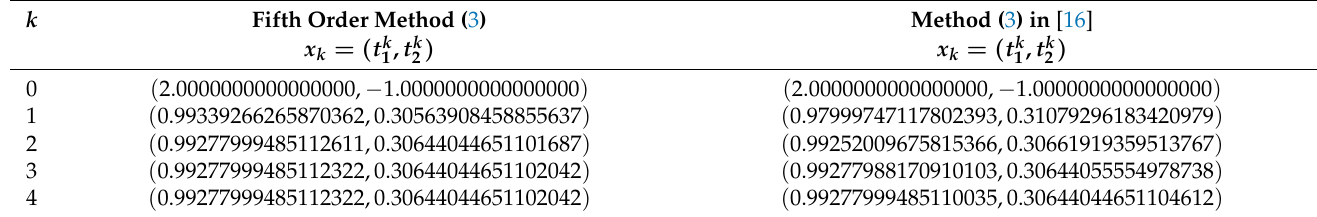
Table 4. Fifth-Order Method (3) and the Noor–Waseem Fifth-order Extension Method in [16].